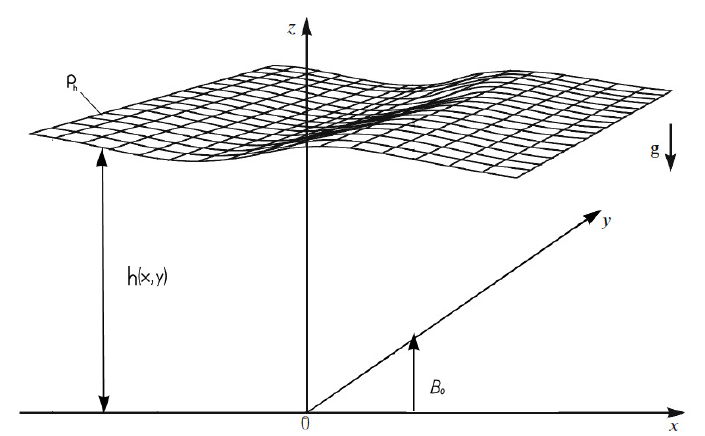
Figure 20. Geometry of the a layer of compressible